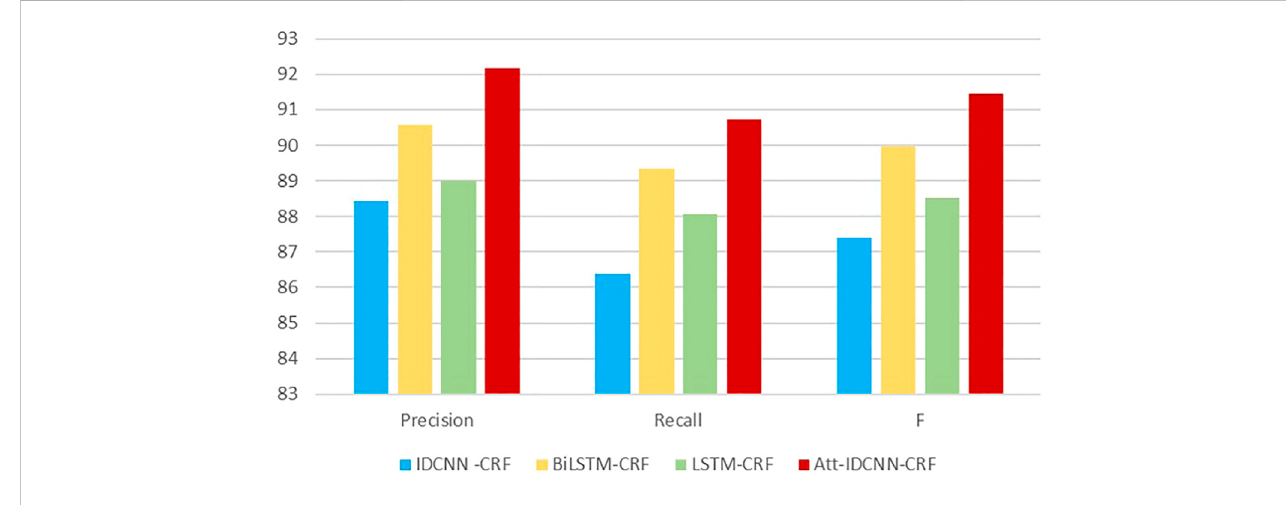
FIGURE 5 Chart of precision, recall, and F-statistic